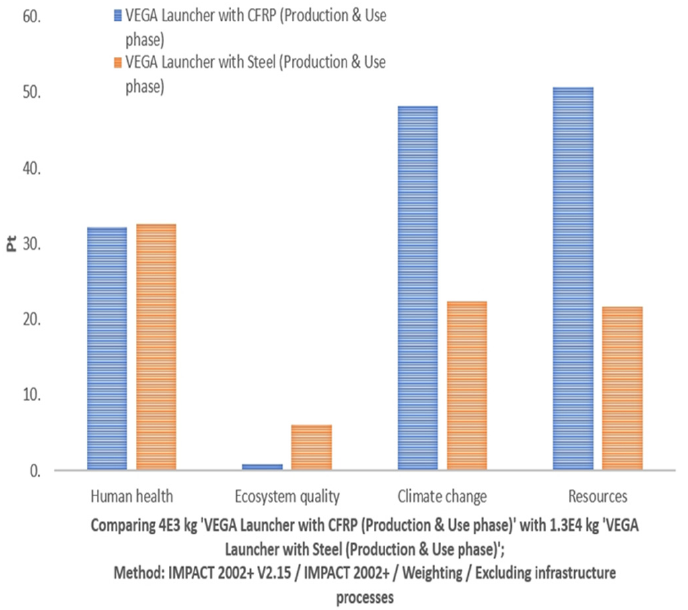
Figure 8. LCA results of overall comparison of production and use phases of stainless steel and CFRPs.